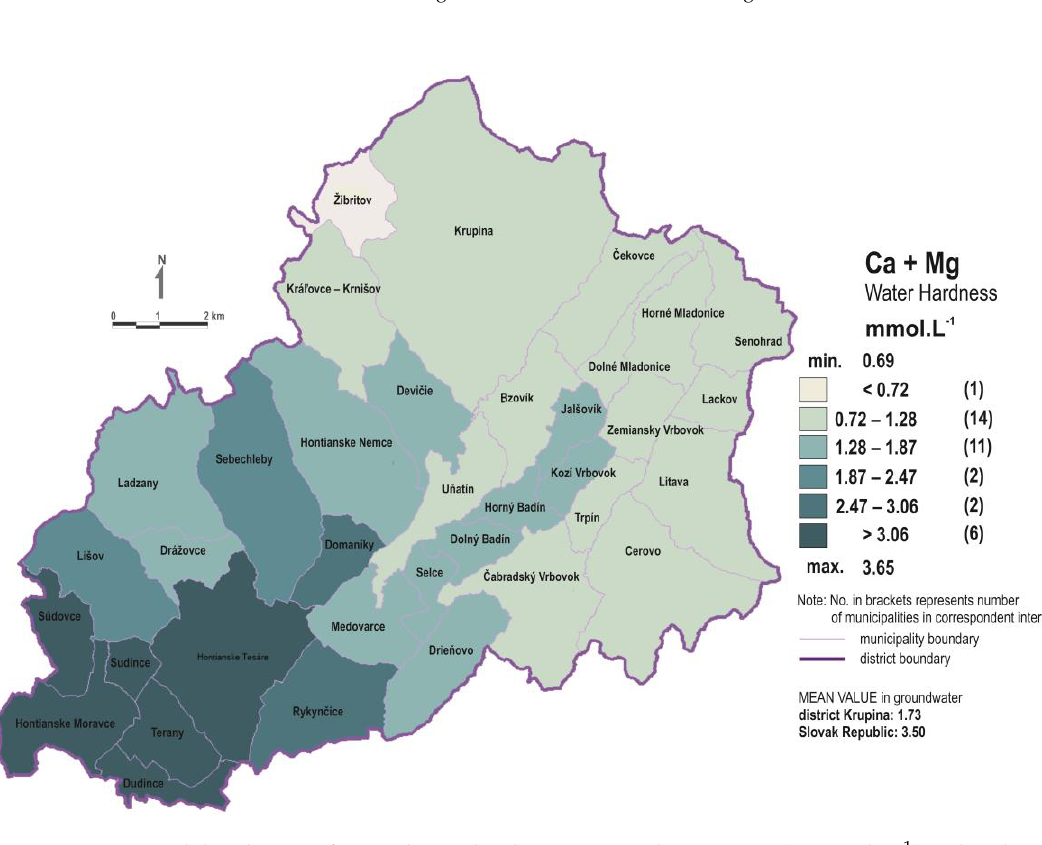
Figure 2. Spatial distribution of groundwater hardness expressed as Ca + Mg (in mmol·L − 1 ) within Krupina district. Note the much higher water hardness in the south-western part of the